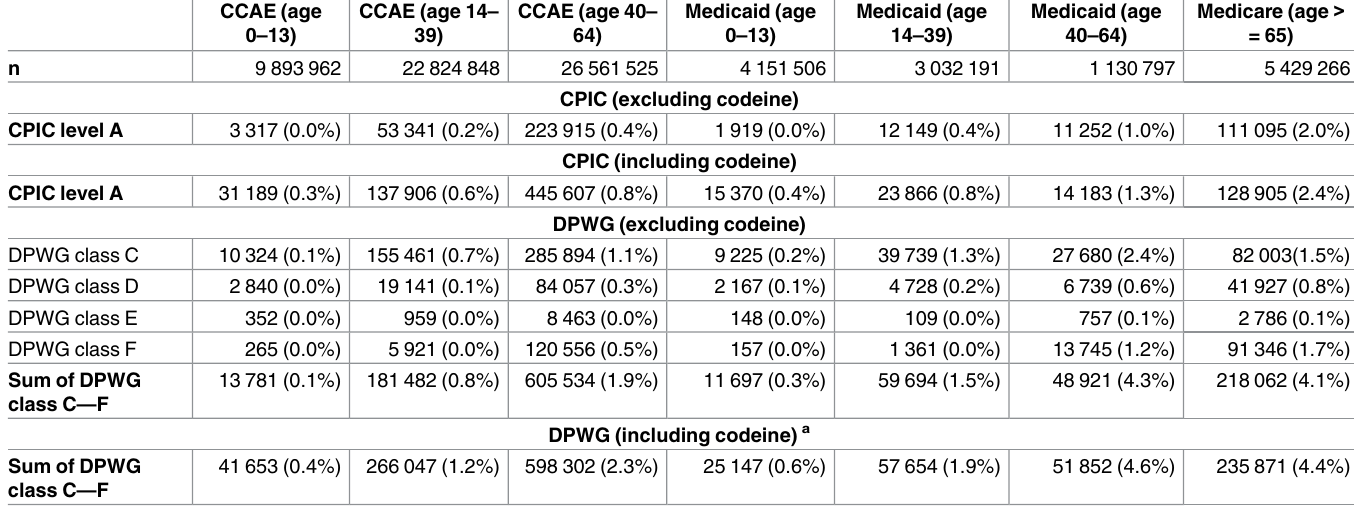
Table 5. Number of expected drug-phenotype co-occurrences of highest priority according to CPIC guidelines (CPIC level A) or high clinical sig- nificance according to DPWG guidelines (DPWG clinical significance classes C–F) within the observed four-year time window. PGx drugs includedin all estimations: amitriptyline, azathioprine, clomipramine, clopidogrel,doxepin, glimepiride,haloperidol, imipramine, mercaptopurine, metoprolol, nortriptyline, paroxetine, propafenone, risperidone sertraline, tamoxifen, thioguanine,tramadol, venlafaxine. Estimations which additionallyincludedcodeine are shown for comparison. The rationalefor including / excludingdrug substancesis describedin the Methods section (‘Drug substancesincludedin the